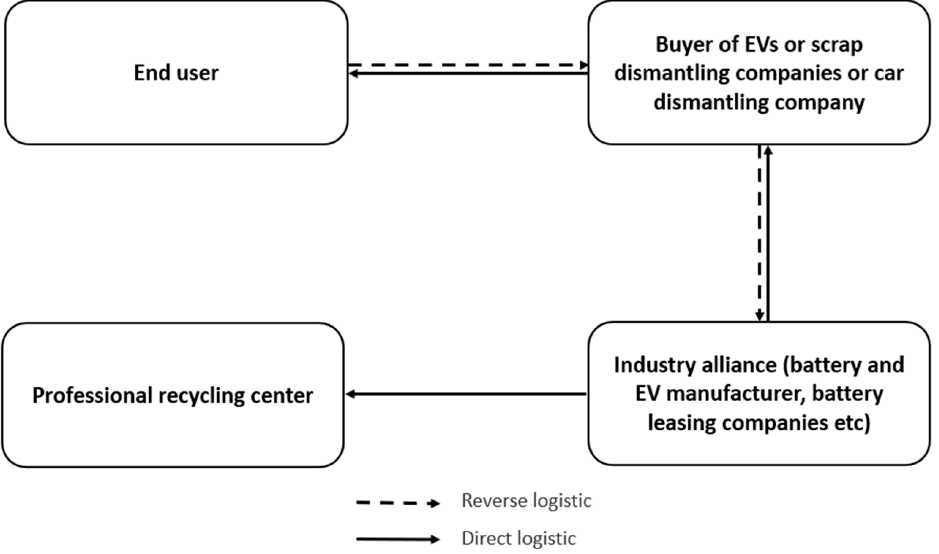
Figure 5. Lithium-ion battery reverse-chain in Europe and North America. Adapted from [33].